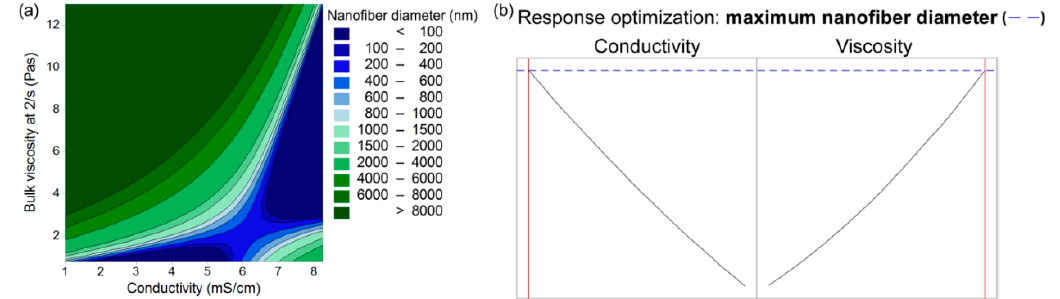
Figure 9. ( a ) contour plot of the resulting nanofiber diameter as a function of the polymer-blend solution conductivity and bulk viscosity; ( b ) response optimization of the resulting nanofiber diameter as a function of the polymer-blend solution conductivity and bulk viscosity.